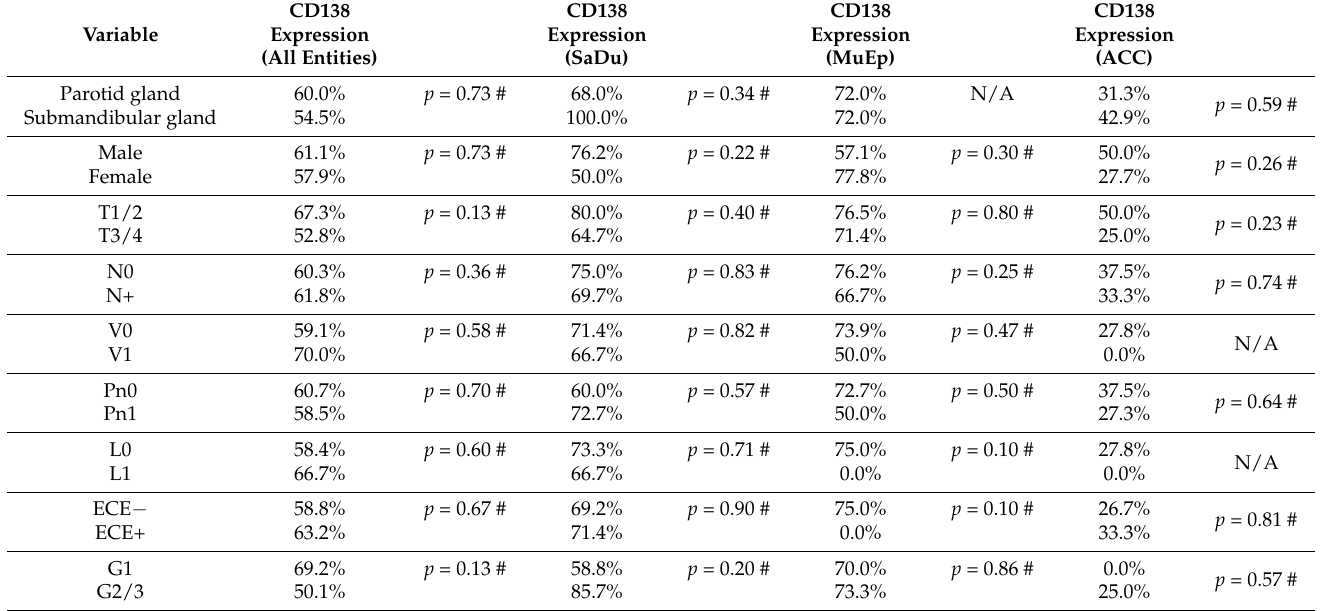
Table 2. Statistical association between localization of the primary tumor, sex, histopathological data, and immunohistochemical CD138 expression (yes vs. no) for all entities and for the most frequent entities salivary duct carcinoma (SaDu), mucoepidermoid carcinoma (MuEp), and adenoid cystic carcinoma (ACC).